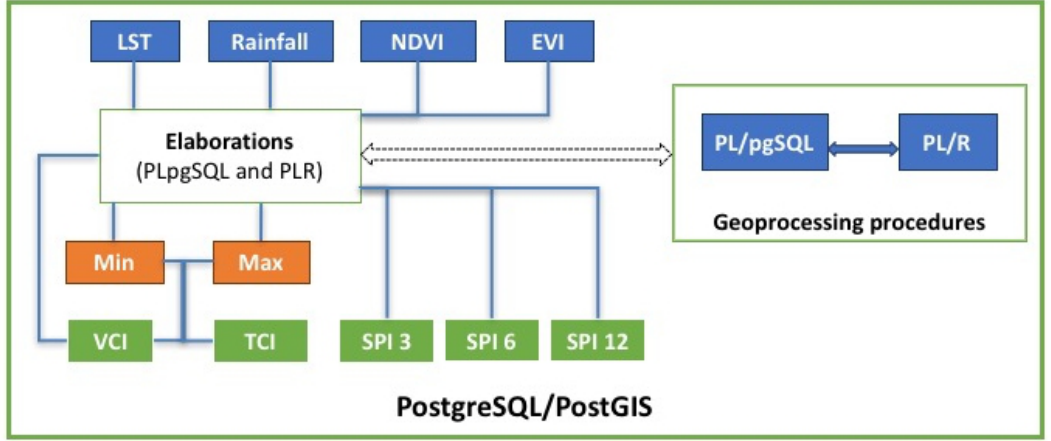
Figure 7. GeoDB components of the framework